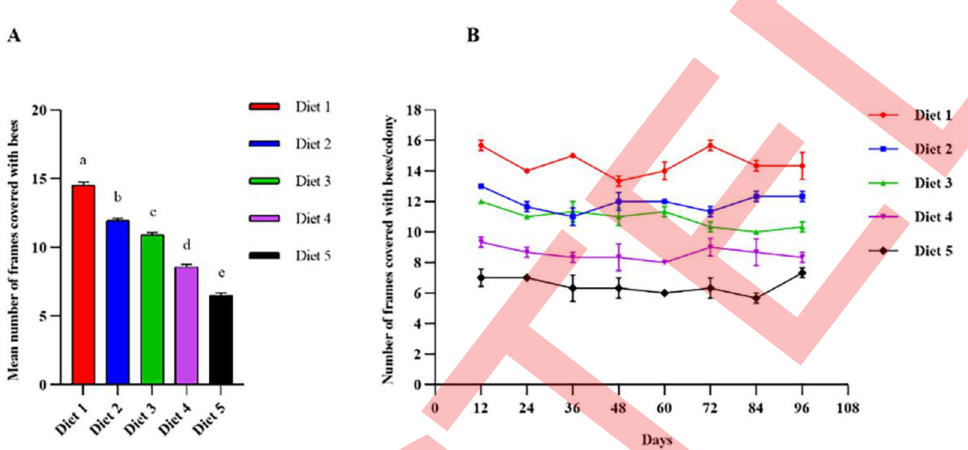
Fig 4. The number of frames (shows as mean ± standard error) with bees recorded after the consumption of various diets. (A), the mean number of frames over the time of observation. (B), the mean number of frames with bees after each twelve days intervals.